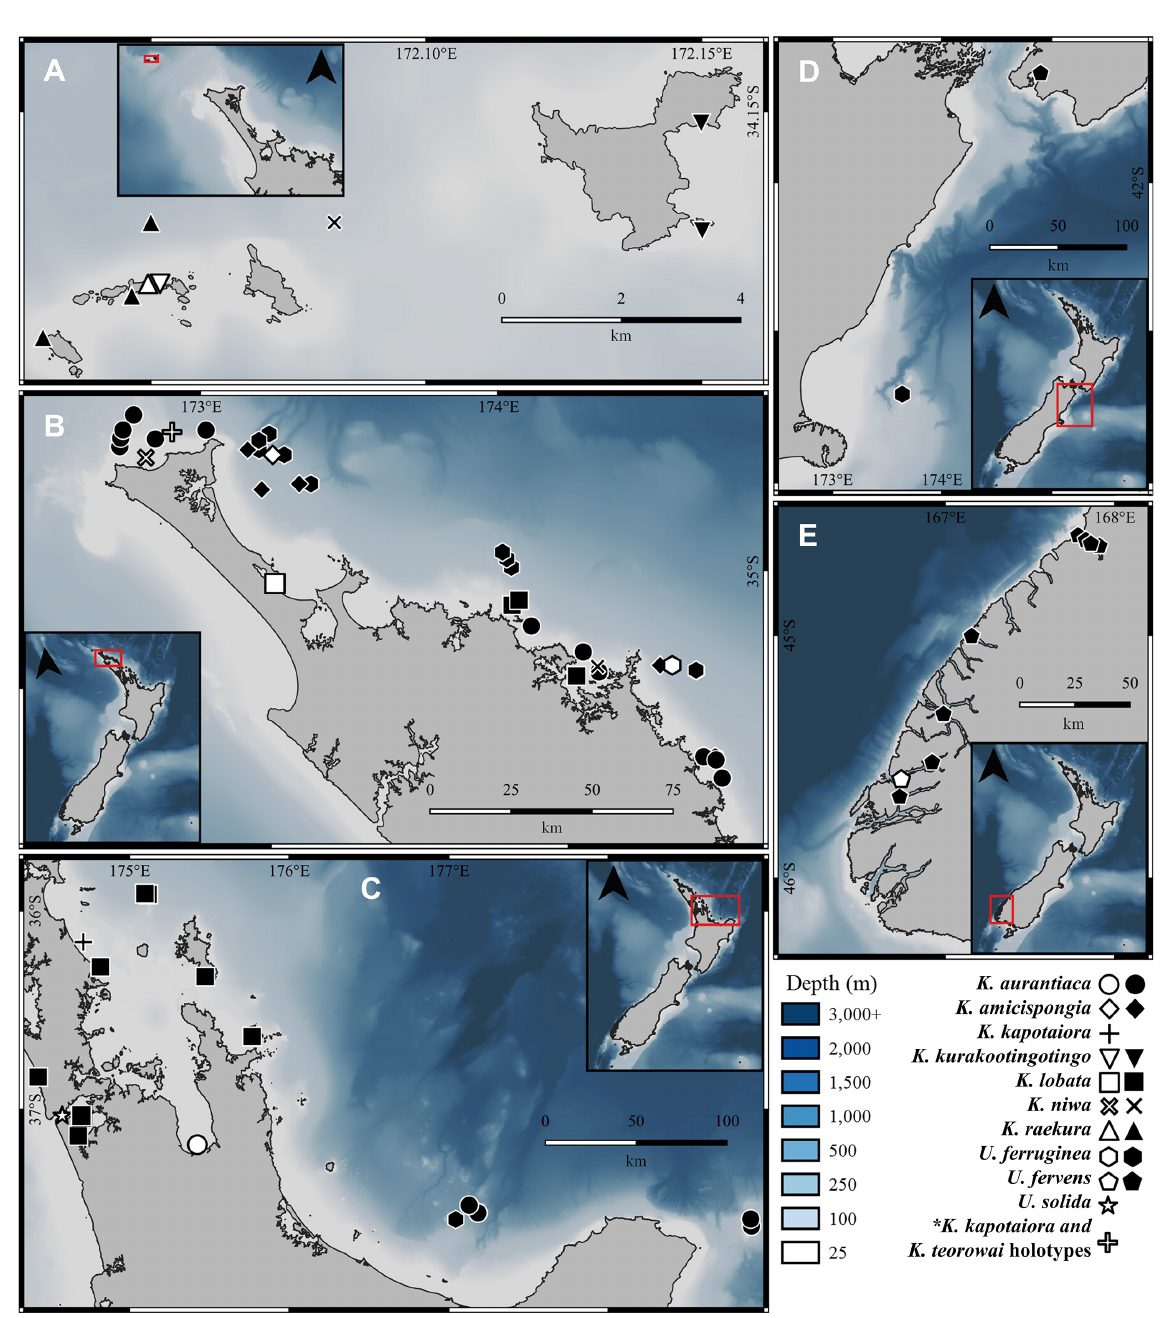
Fig. 1. Collection sites of specimens of Kotatea gen. nov. and Ushanaia gen. nov. Holotype collection sites are indicated by white symbols, paratypes and other material by black symbols. In the case of K. aurantiaca gen. et comb. nov., the type collection site refers to that described by Quoy & Gaimard (1833). A . Manawatāwhi/Three Kings Islands. B . Far northern NZ, from Piwhane/Spirits Bay to the Poor Knights Islands. C . Northern NZ, from the Mokohinau Islands to East Cape. D . Central NZ, Cook Strait to Banks Peninsula. E . South-East NZ, Fiordland. Note that the holotypes of K. kapotaiora gen. et sp. nov. and K. teorowai gen. et sp. nov. share the same collection